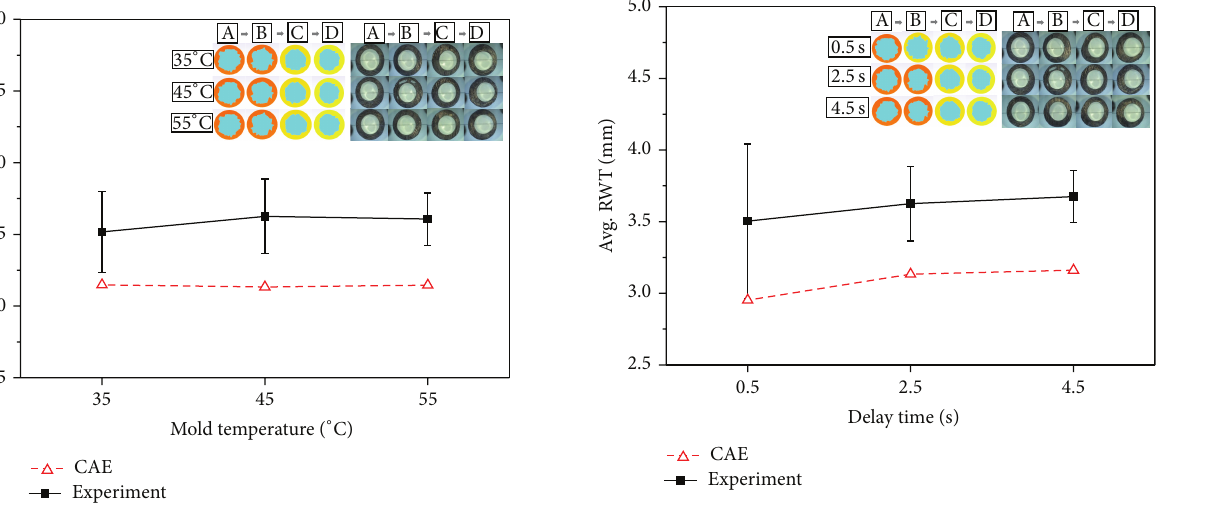
Figure 13: Effect of delay time on average residual wall thickness for the experiment and analysis